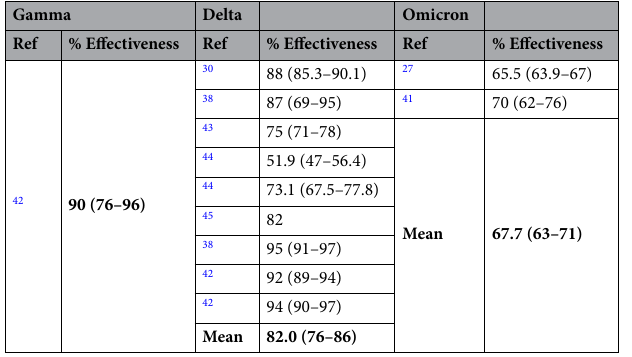
Table 4. Reported vaccine effectiveness after 2 doses for the SARS-CoV-2 variants indicated in the table. Parentheses are 95% CI (if given in the study). Numbers in bold are means of vaccine effectiveness and 95%